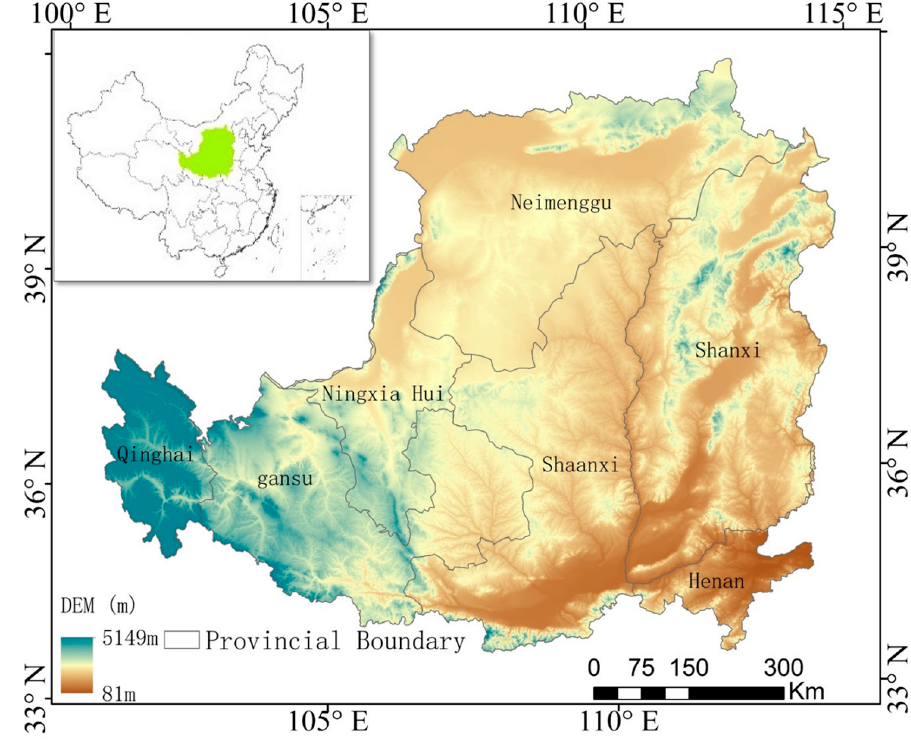
Figure 1. The location map of the Loess Plateau.